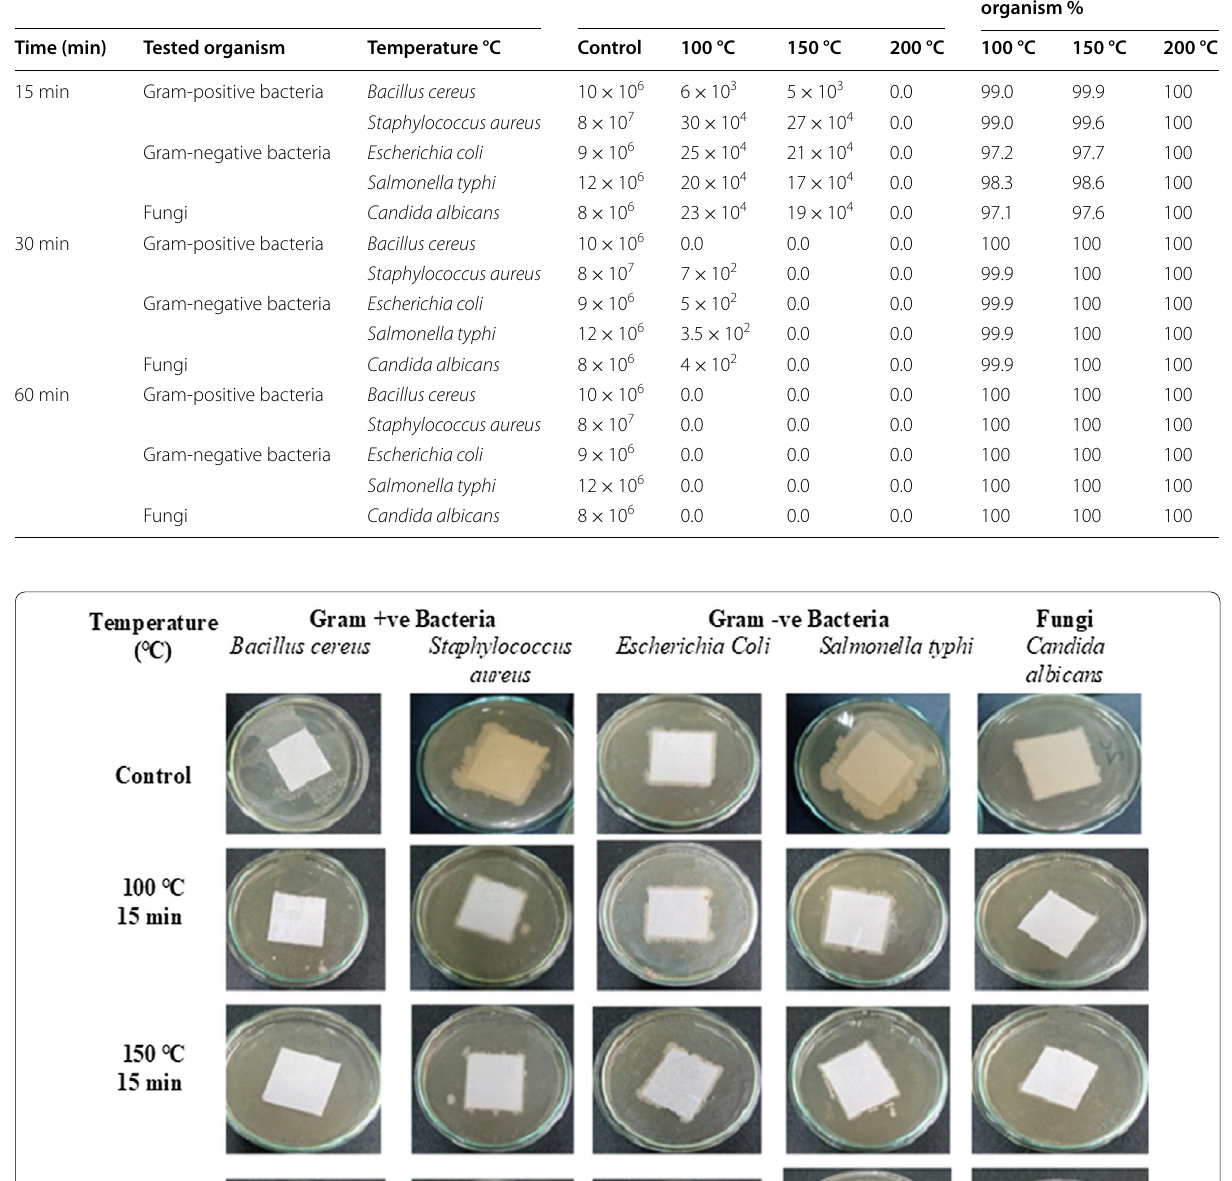
Table 2 The efficiency of dry heat at different periods in the sterilization of pathogenic contaminated paper Treatments Average no. of organisms